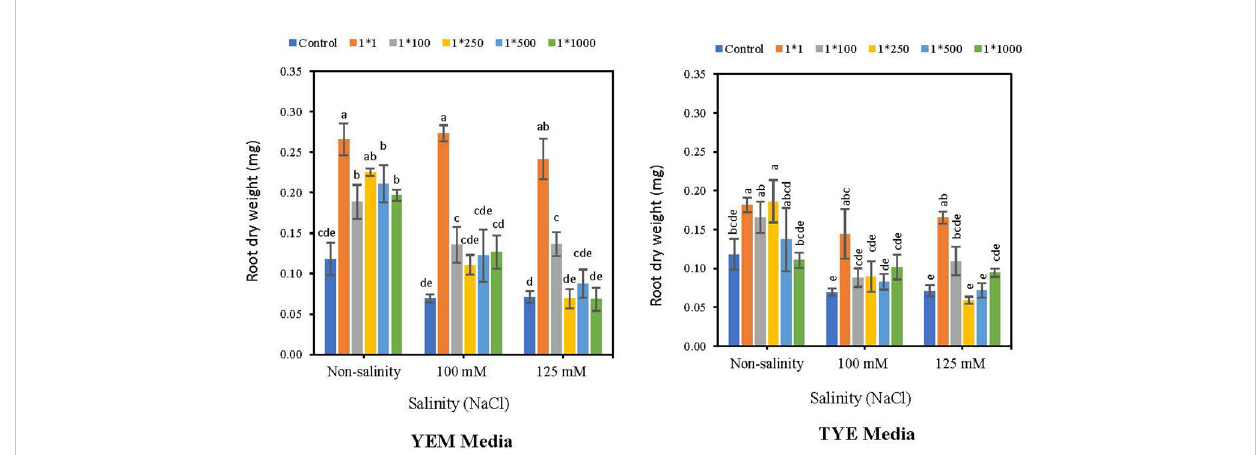
FIGURE 8 Effect of dilutions of Devosia sp. YEM(B)-CFS and TYE(B)-CFS and salinity on Root dry weight of soybean seedlings. Values represent the mean of four replicates ± SD. 1:1, 1:100, 1:250, 1:500 and 1:1000 = 1 mL Devosia sp. CFS and 1, 100, 250, 500 and 100 mL distilled water,